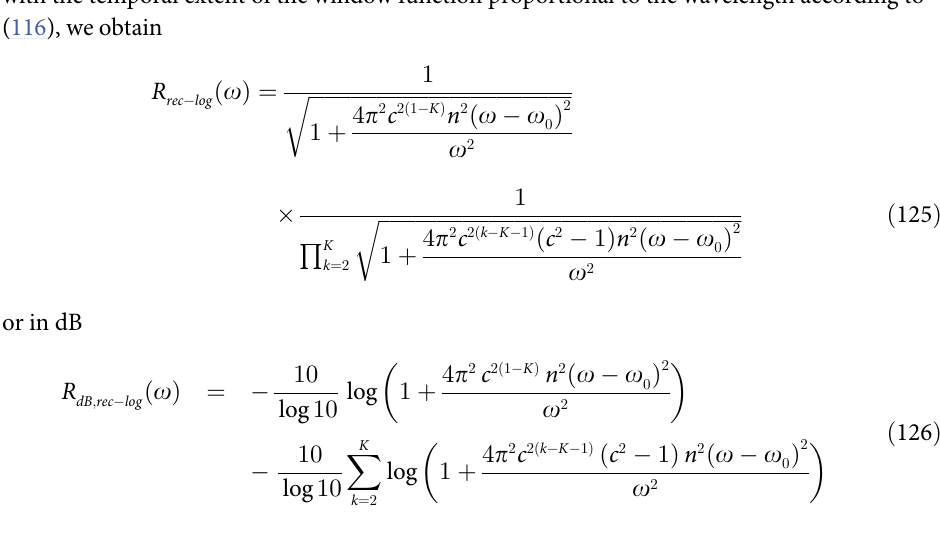
ffiffiffi p 2 or c = 2. (Horizontal axis: Angular